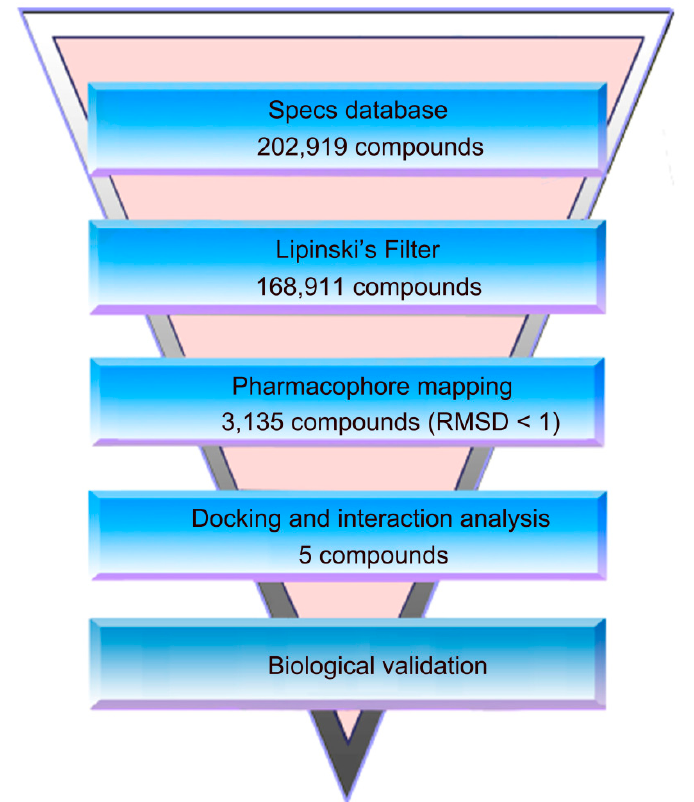
Figure 2. A workflow overview of pharmacophore modeling, selection of compounds, and biological testing.